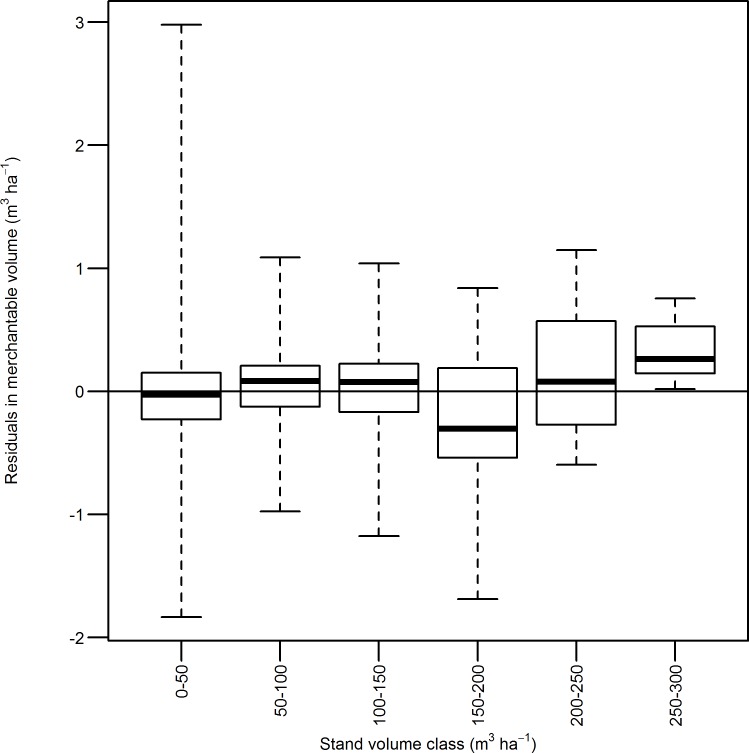
Boxplot of residuals of Eq (5) in stand merchantable volume estimation against stand volume classes.